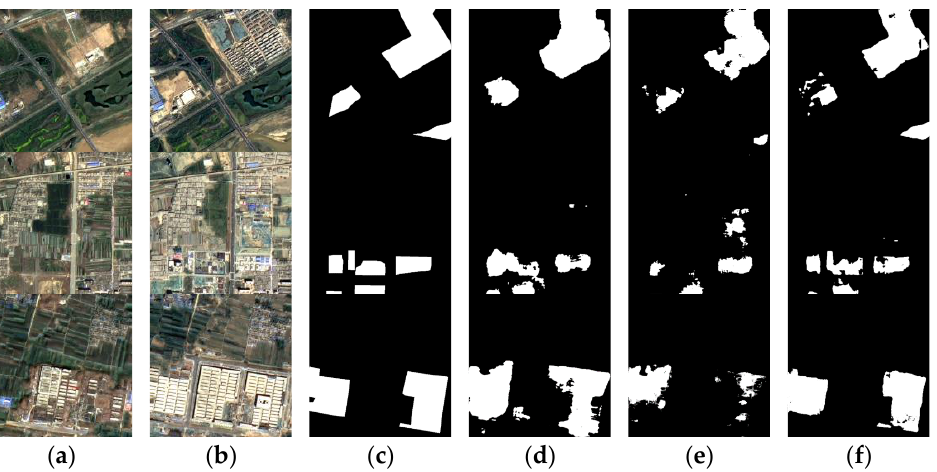
Figure 13. Sub-region change detection results: ( a ) image before the change, ( b ) image after the change, ( c ) ground truth, ( d ) detection results of SLN, ( e ) detection results of FC-Siam-diff, and ( f ) detection results of UNET-CD.